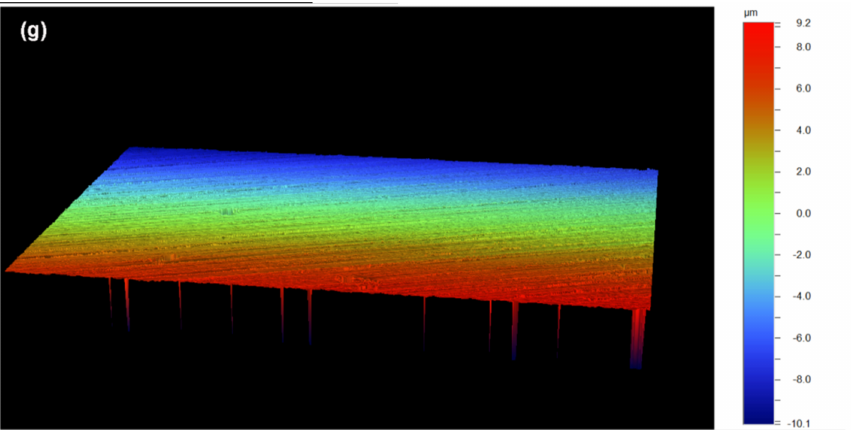
Figure 5. Surface topography characteristics measured by a 3D optical profilometer after the polishing treatment of the obtained dental nanocomposite resins containing 60 wt% of: ( a ) neat silica; ( b ) MPS; ( c ) OTMS; ( d ) ACPS; ( e ) MPS-OTMS; ( f ) ACPS-OTMS; and ( g ) MPS-ACPS-treated silica